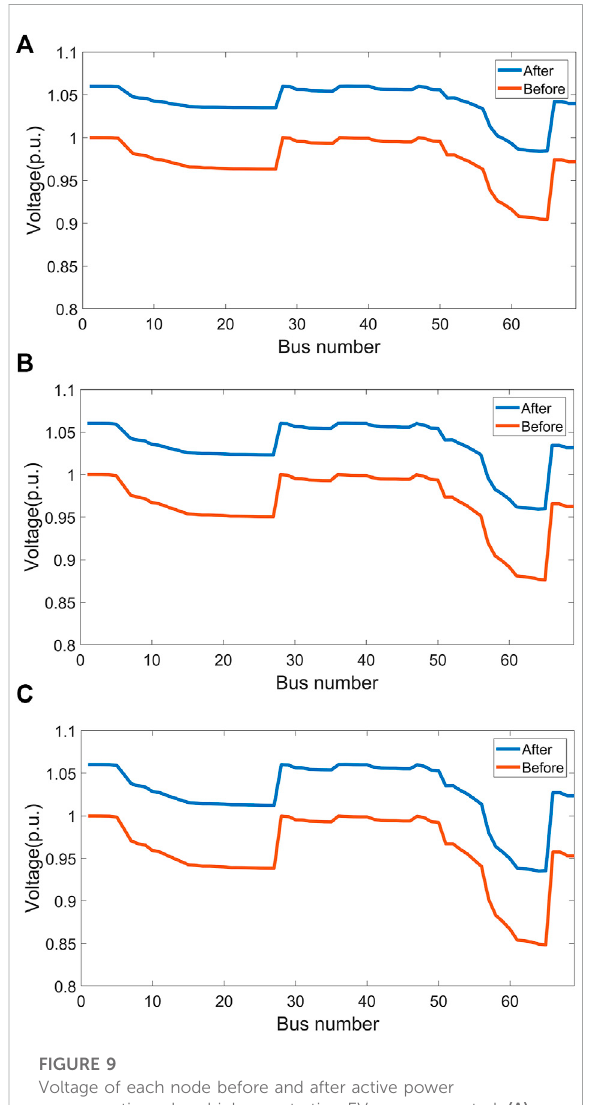
FIGURE 9 Voltage of each node before and after active power compensation when high-penetration EVs are connected. (A) Lightload0.73p.u. (B) Nominalload1p.U. (C) Heavyload1.25p.U.